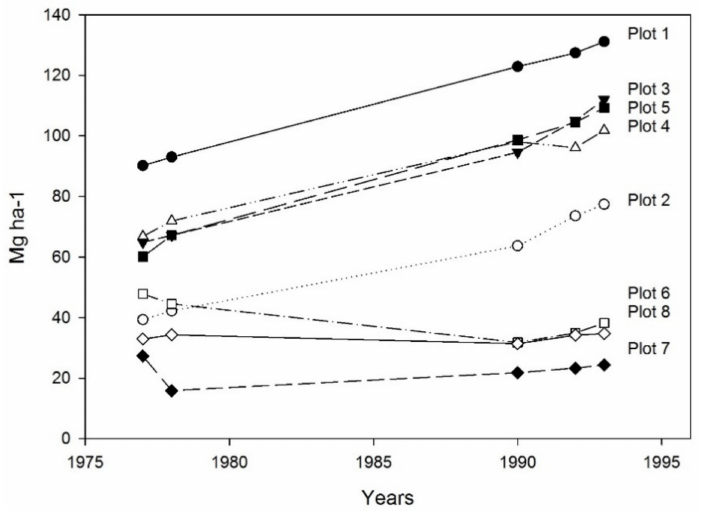
Figure 5. Variation in old-growth biomass as measured in eight sites in Kitulango Forest Reserve, Tanzania over a period of 15 years. Source: Graph by the authors based on data in